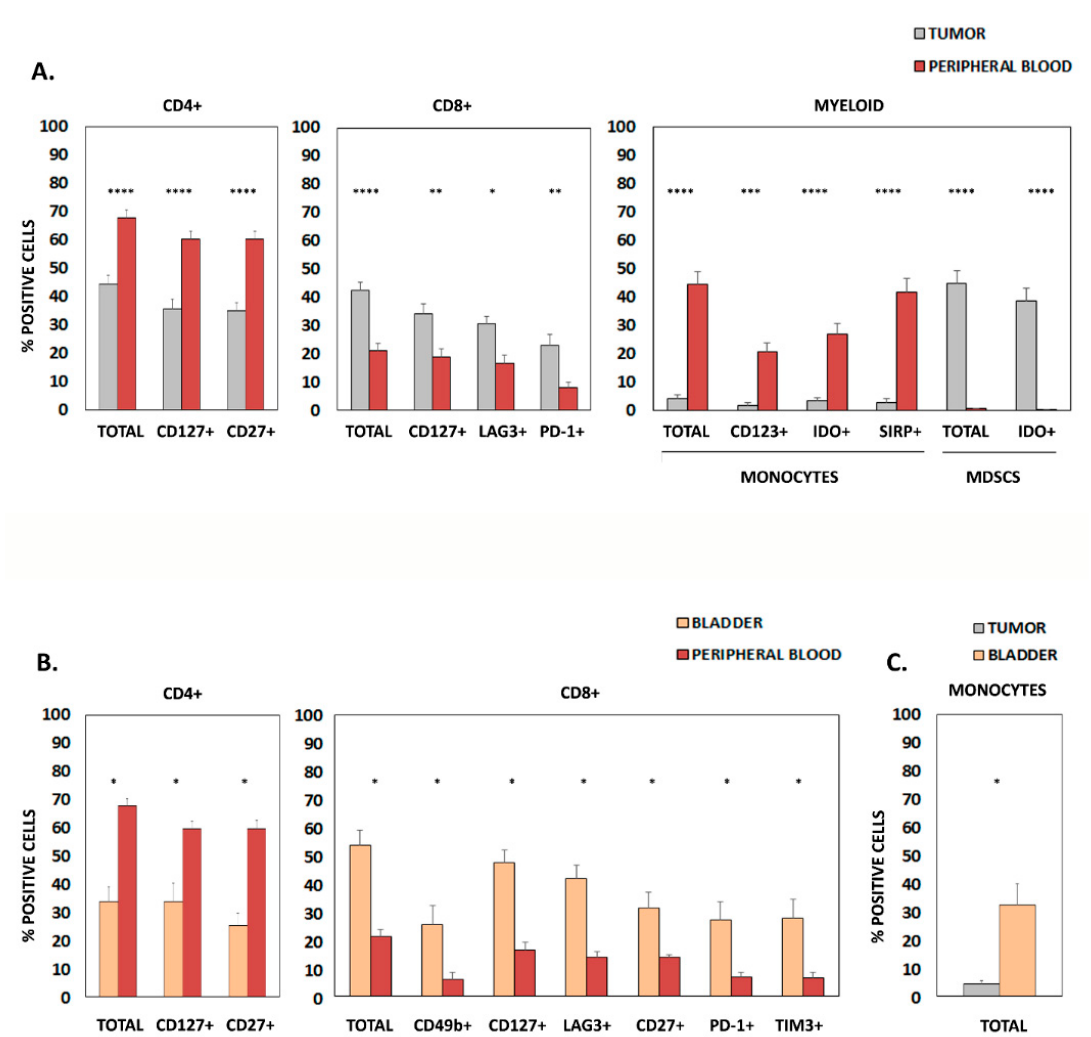
Figure 1. Markers differentially expressed in samples from patients with urothelial bladder cancer. ( A ) Graphics show differentially expressed surface molecules in CD4+ lymphocytes, CD8+ lymphocytes, and monocytes from patient tumor samples and peripheral blood. ( B ) Differentially expressed surface molecules in CD4+ lymphocytes, CD8+ lymphocytes, and monocytes from patient bladder tissue and peripheral blood. ( C ) Differentially expressed markers in monocytes from patient bladder tissue and tumor samples. In all cases, only statistically significant results (Mean + SD of % positive cells) are shown; * p < 0.05; ** p < 0.01; *** p < 0.001; **** p < 0.0001. MDSC, myeloid-derived suppressor cells.